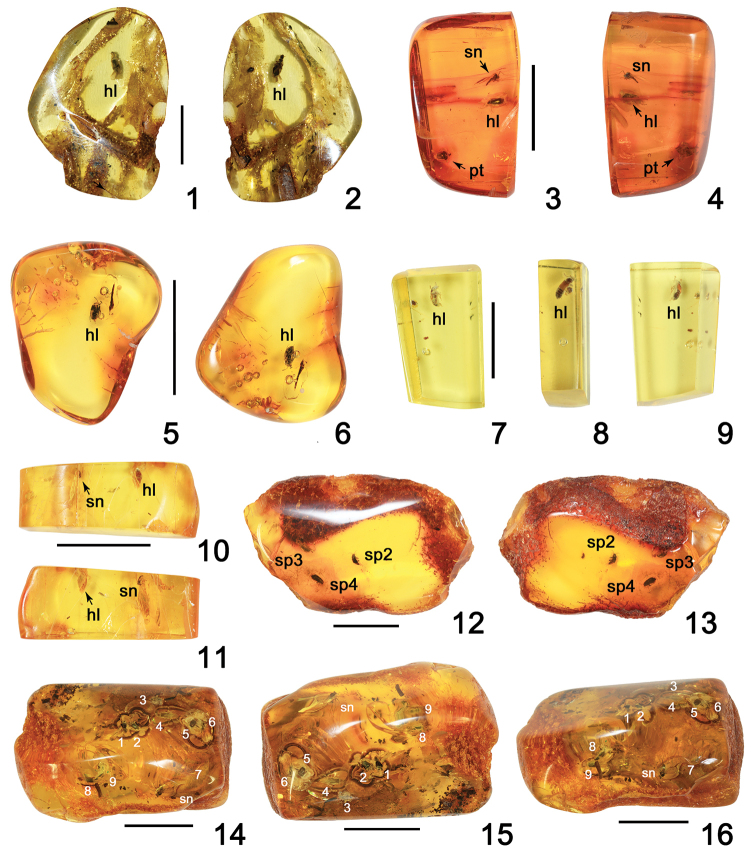
Amber specimens with inclusions of Omaliinae: 1, 2Geodromicusbalticus sp. nov. 3, 4Eusphalerumkanti sp. nov. 5, 6Paraphloeostibamorosa sp. nov. 7–9Phyllodrepadaedali sp. nov. 10, 11Ph.icari sp. nov. 12, 13Eusphalerum sp. 2 (sp2), Eu. sp. 3 (sp3) and Eu. sp.4 (sp4) 14–16Eu. sp. 1 (specimens 1 to 9 (in the text: no. 1 to no. 9). Abbreviations: hl = holotype, pt = paratype, sn = syninclusion. Scale bars: 1.0 cm (1–6, 10–16), 0.5 cm (7–9).